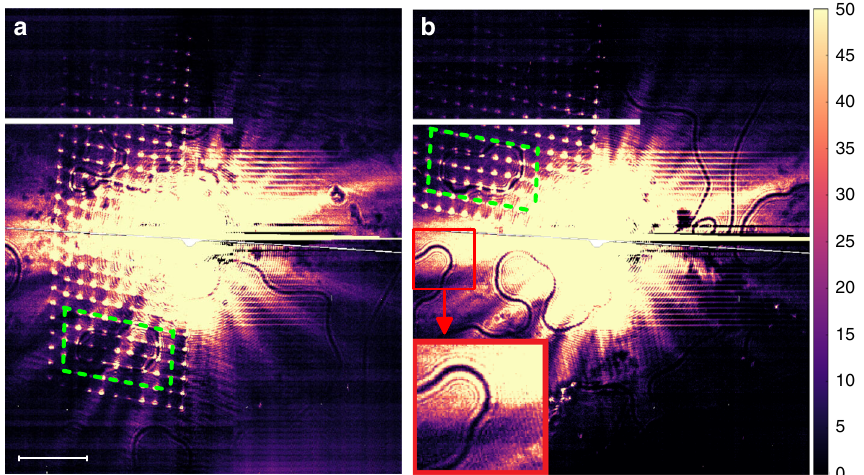
Fig. 4 Coordinate grid on the sample surface. a A single-exposure image showing an array of bright spots that were produced by a prolonged beam exposure at numerous positions on the sample surface. The vertical and horizontal distance between the adjacent dots is 10 µ m. In this measurement, the whole cryostat was moved to achieve different beam positions on the sample for spot burning. This gives rise to the tilt of the axes in the spot array. The beam can also be moved on the sample surface by the pinhole translation with little axis tilt, but a smaller motion range is achievable in this case. b Image was taken at a different position of the beam on the sample surface. Dashed green lines forming a parallelogram in each fi gure go through the same spots on the sample surface in both images, and the two parallelograms cover the same physical area on the sample surface. The dark lines inside the parallelograms go through the same physical coordinates in both a and b . This provides a de fi nite evidence that the lines in the images result from the corresponding features on the physical surface of the sample. A blowup of a small image region demonstrating the fringe pattern surrounding the central dark line is shown in the lower left corner in b . Regularly-spaced horizontal straight lines are artifacts due to detector saturation. Horizontal scale bars (50 µ m) refer to the distances on the sample surface. Vertical color scale-bar units are